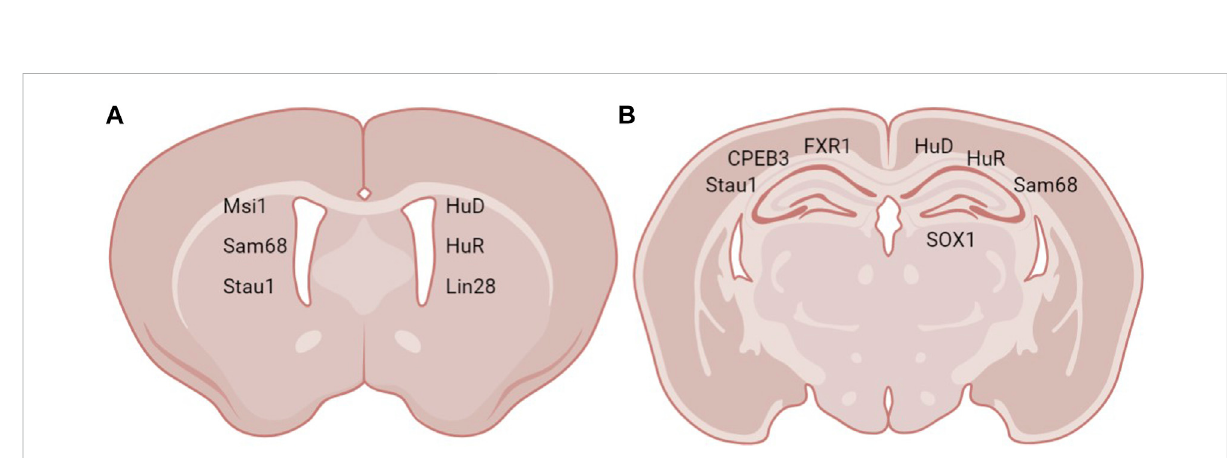
FIGURE 2 Expression sites of RBPs in neurogenic regions. RBPs expressed in (A) the SVZ and (B) the hippocampus.